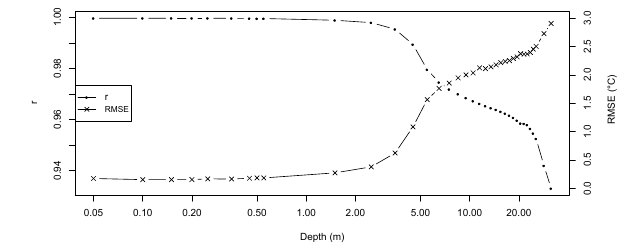
Figure 5. Cool skin effect ( (cid:49)T c ) as a function of wind speed ac- cording to several empirical parameterisations.